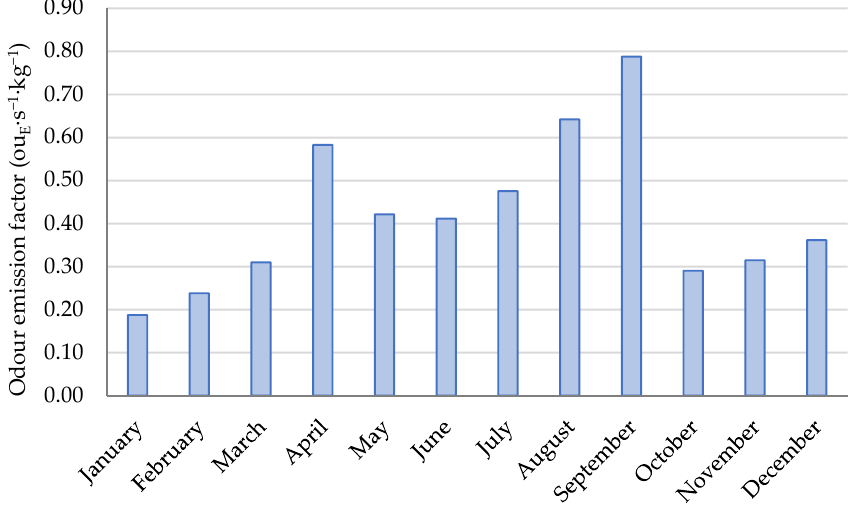
Figure 10. Odour emission factors for fattening pigs.